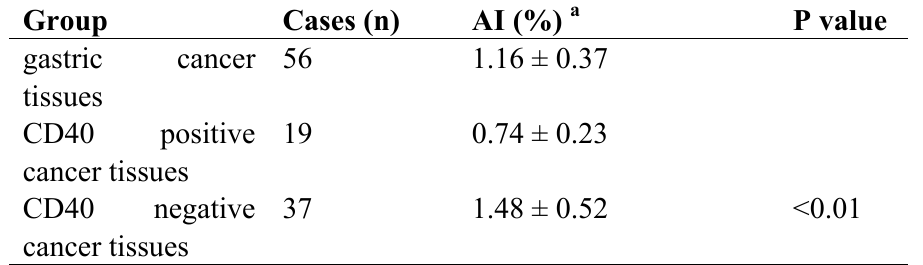
Table 5. Correlation of CD40 expression with apoptotic index (AI) in gastric cancer